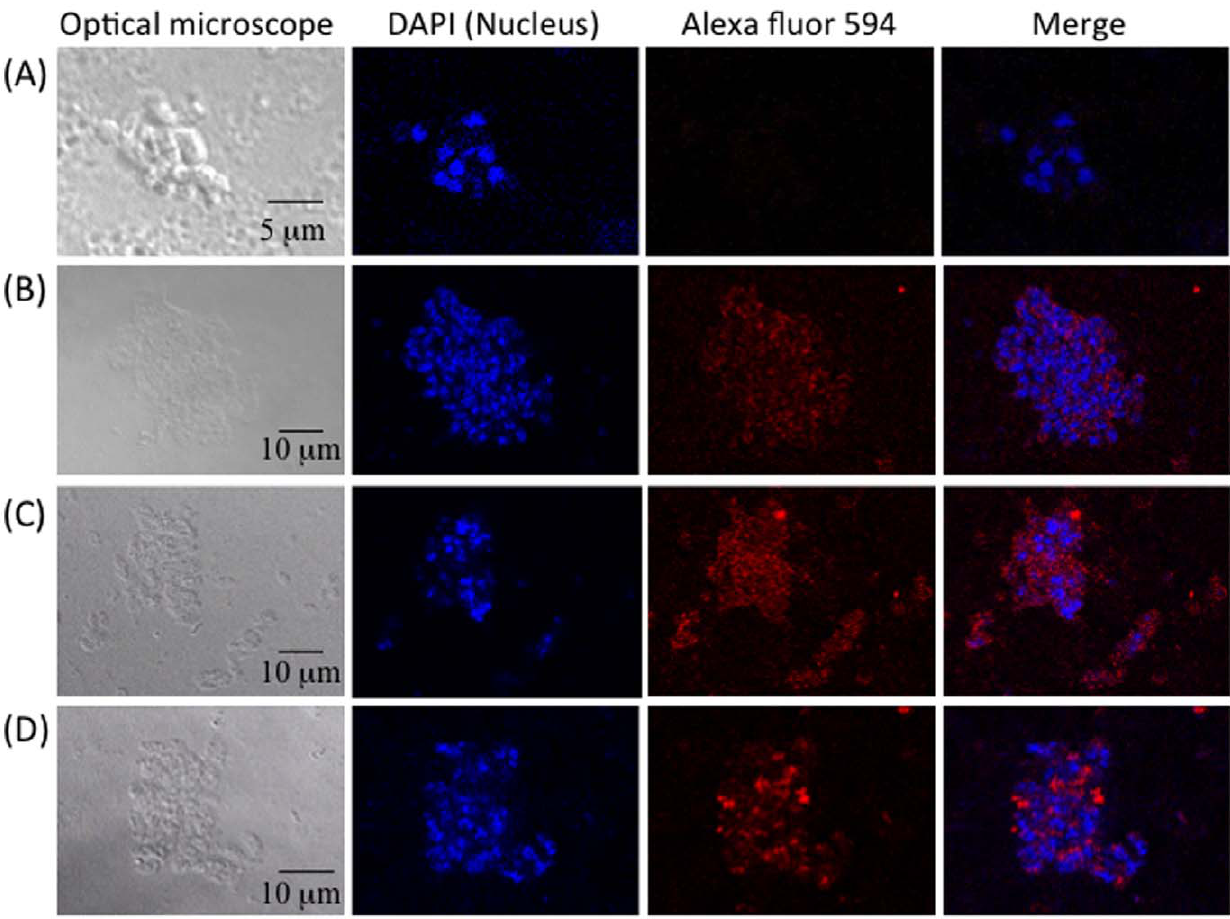
Figure 4. Immunofluorescence assay of N.caninum with monoclonal antibodies. N. caninum was immobilized and blocked following by addition of sample without primary antibody (A), A10 Fab (B), H3 Fab (C), and a commercial anti- Neospora antibodies (D). For Fab samples, anti-FLAG antibody was used as a secondary antibody. Alexa 594 labeled anti-mouse IgG was added finally and observed under a confocal laser-scanning microscope. 4’,6-diamidino-2-phenylindole (DAPI) was used to stain the nuclear of